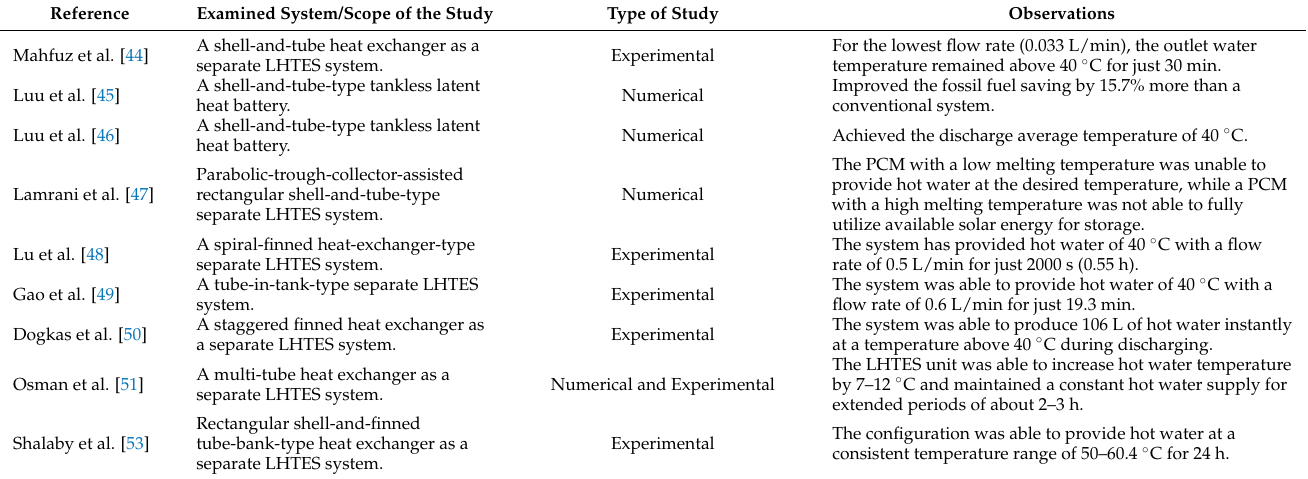
Table 3. Summary of the literature on the hot water systems with a separate LHTES unit.